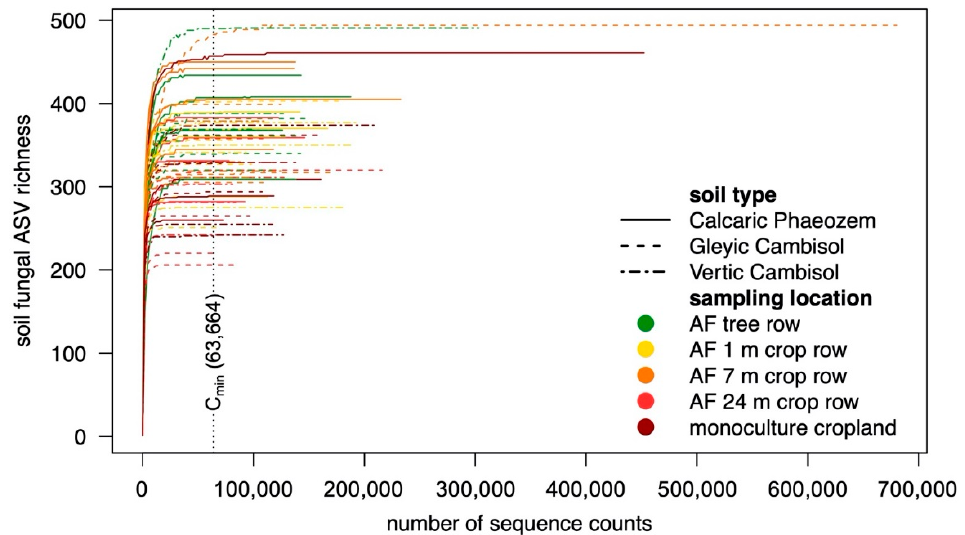
Figure 2. SRS curves and number of sequence counts used for normalization (C min ) using SRS. Step size = 2000 counts. AF = agroforestry system, ASV = amplicon sequence variant, SRS = scaling with ranked subsampling.